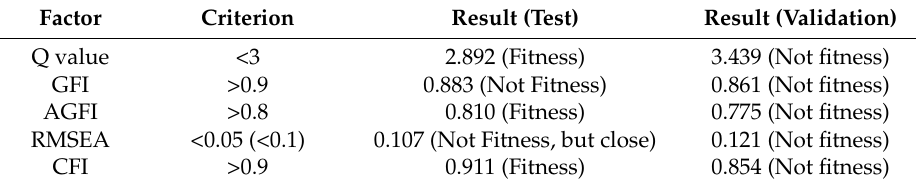
Table 10. Fitness of the structural equation model for effluent T–P.